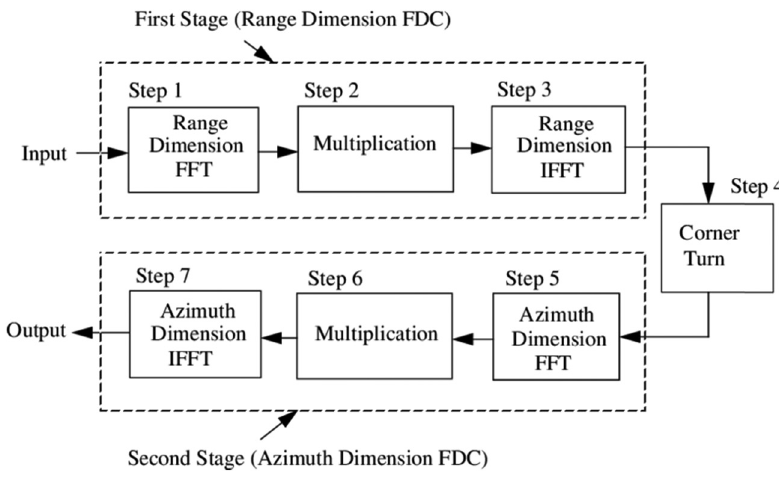
Figure 1: Synthetic aperture radar basic block diagram.